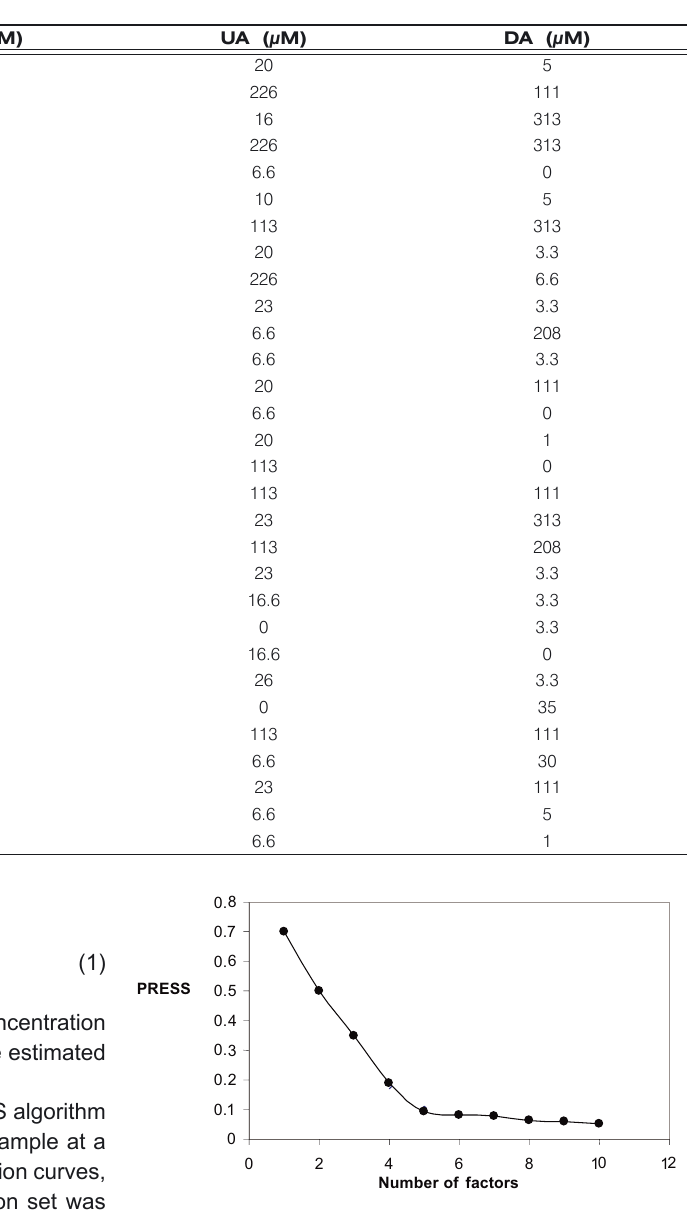
Figure 9. Plot of PRESS against the number of factors for dopamine (calculated according to Eq.